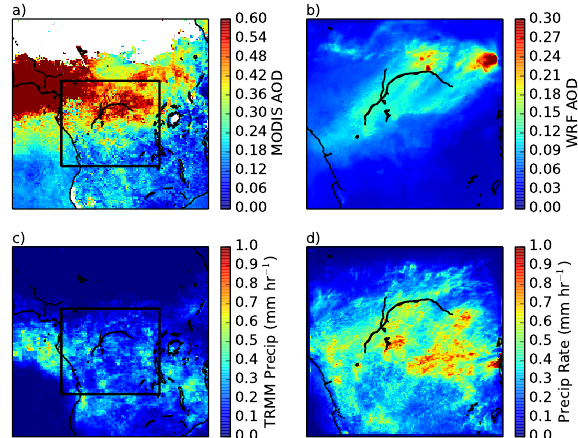
Figure 3. (a) The mean Aqua MODIS AOD in equatorial Africa for March 2007. The box shows the study region. (b) The mean AOD at 13:30 local time for March 2007 from WRF-Chem. Note the change of colour scale. (c) The mean TRMM precipitation rate and (d) the mean WRF-Chem precipitation rate for March